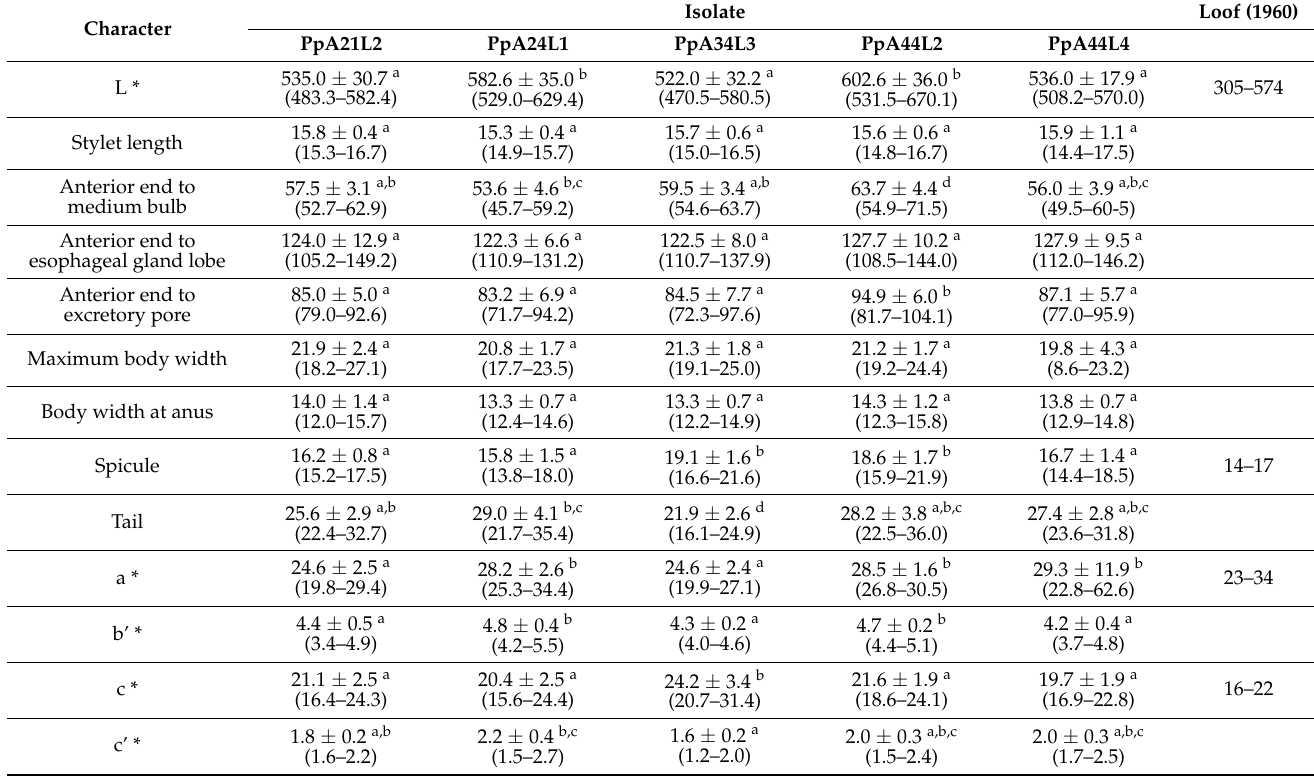
Table 2. Morphometric characters of Pratylenchus penetrans males from Portugal. All measurements are in µ m. Data are means of 10 nematodes ± standard deviation (range). In each row, means followed by the same letters do not differ significantly at p > 0.05, according to the Fisher Least Significant Difference